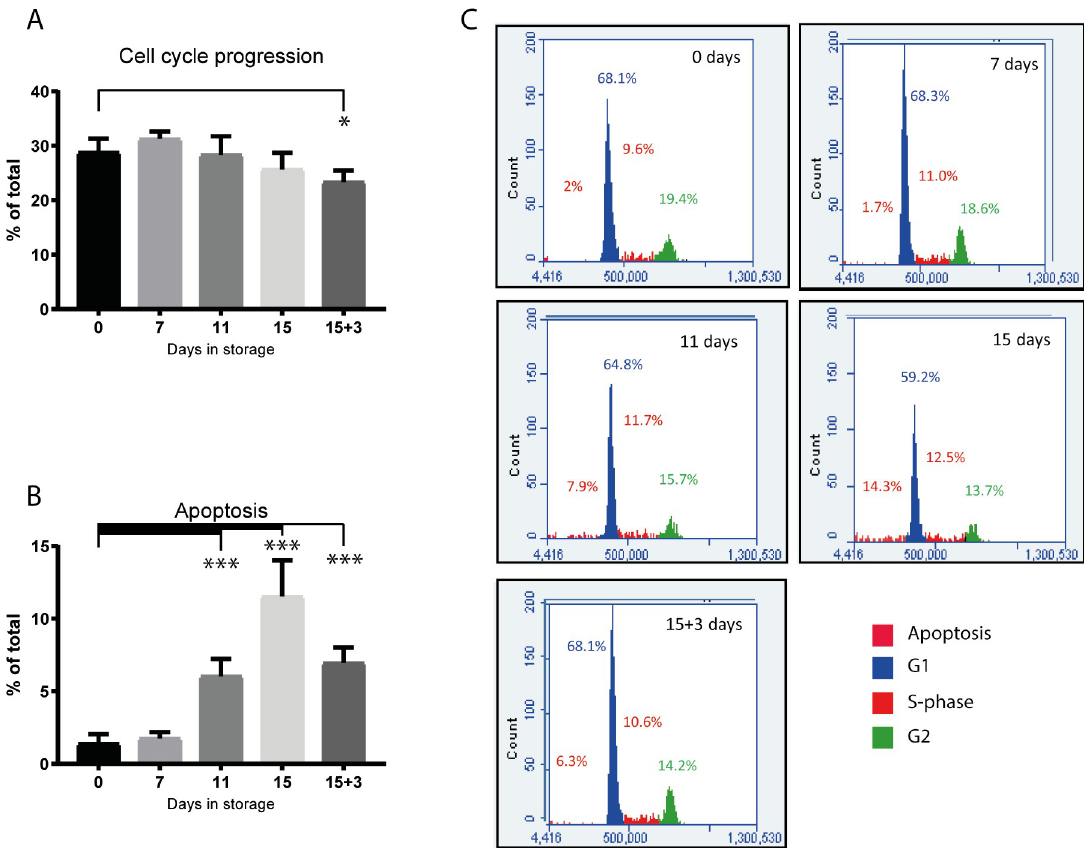
Fig 3. Flow cytometry with Propidium Iodide (PI) was used to measure the percentage of cells preparing to enter or in mitosis (S-, G2- and M-phase combined). The graphs (A) and (B) were prepared using this flow cytometry data. Representative flow cytometry histograms are shown in (C). (A) Number of cells preparing to enter mitosis (S-phase + G2/M) analysed using PI and flow cytometry (n = 6). (B) Percentage of apoptotic cells analysed using PI and flow cytometry (n = 6) (C) Histograms from representative samples showing distribution of cells in apoptosis, G1, S-phase and G2/M. � = significant difference; p = 0.0287; ��� = significant difference; p �